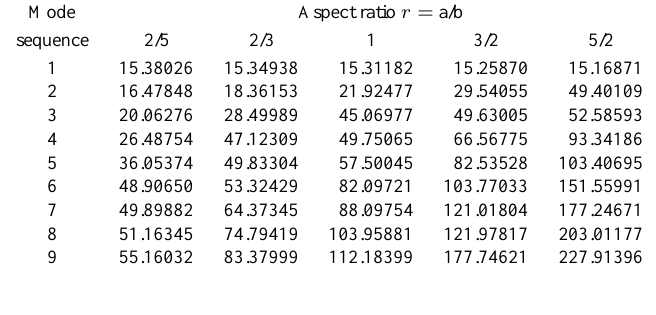
Table 10 Bicubic B-spline solutions of frequency parameters for CGSF plates